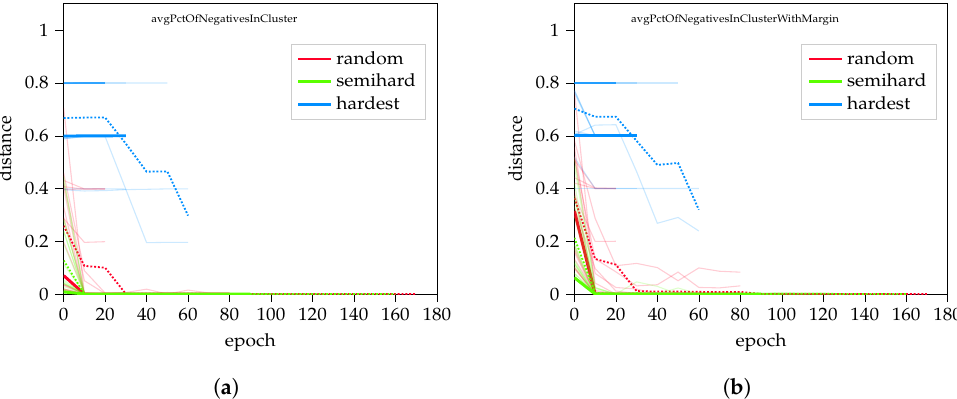
Figure A3. Clustering performance of random hard, negative mining. ( a ) The percentage of negatives in cluster compared with all other elements; ( b ) the same in marginal